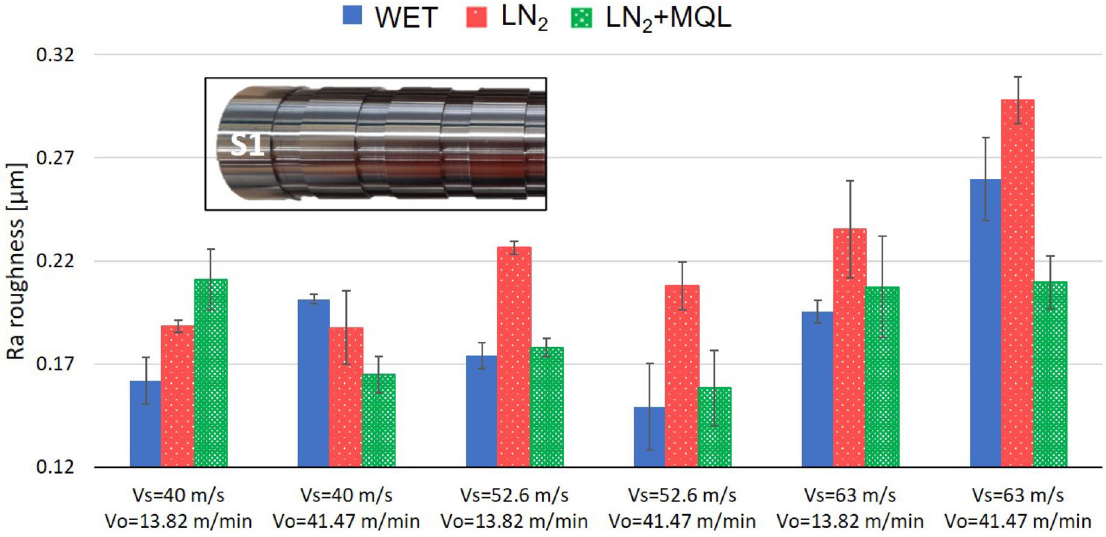
Figure 3. Surface roughness of first ground